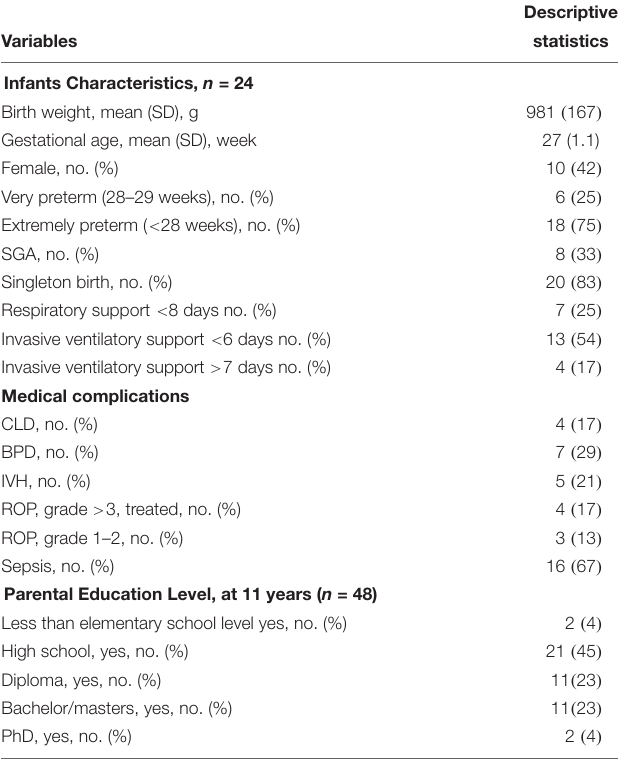
TABLE 1 | Characteristics of preterm infants and parents’ educational level, Swedish CAP cohort.